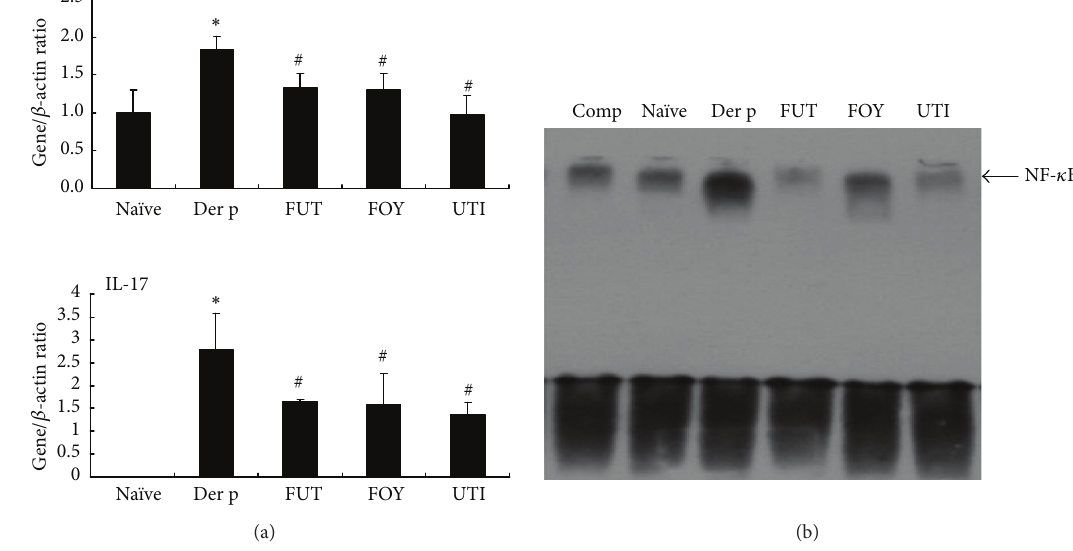
Figure 6: Effects of protease inhibitors on IL-6 and IL-17A gene expression and NF- 𝜅 B activity in lung tissue. (a) Relative IL-6 and IL-17A mRNA expression in lung tissue. Results are expressed as means ± SDs for 6 mice/group. ∗ 𝑃 < 0.05 versus na¨ıve group; # 𝑃 < 0.05 between Der p-treated groups and (b) EMSA showed that all three serine protein inhibitors decreased NF- 𝜅 B activation in lung tissue after Der p stimulation. The arrow indicates the specific DNA-probe